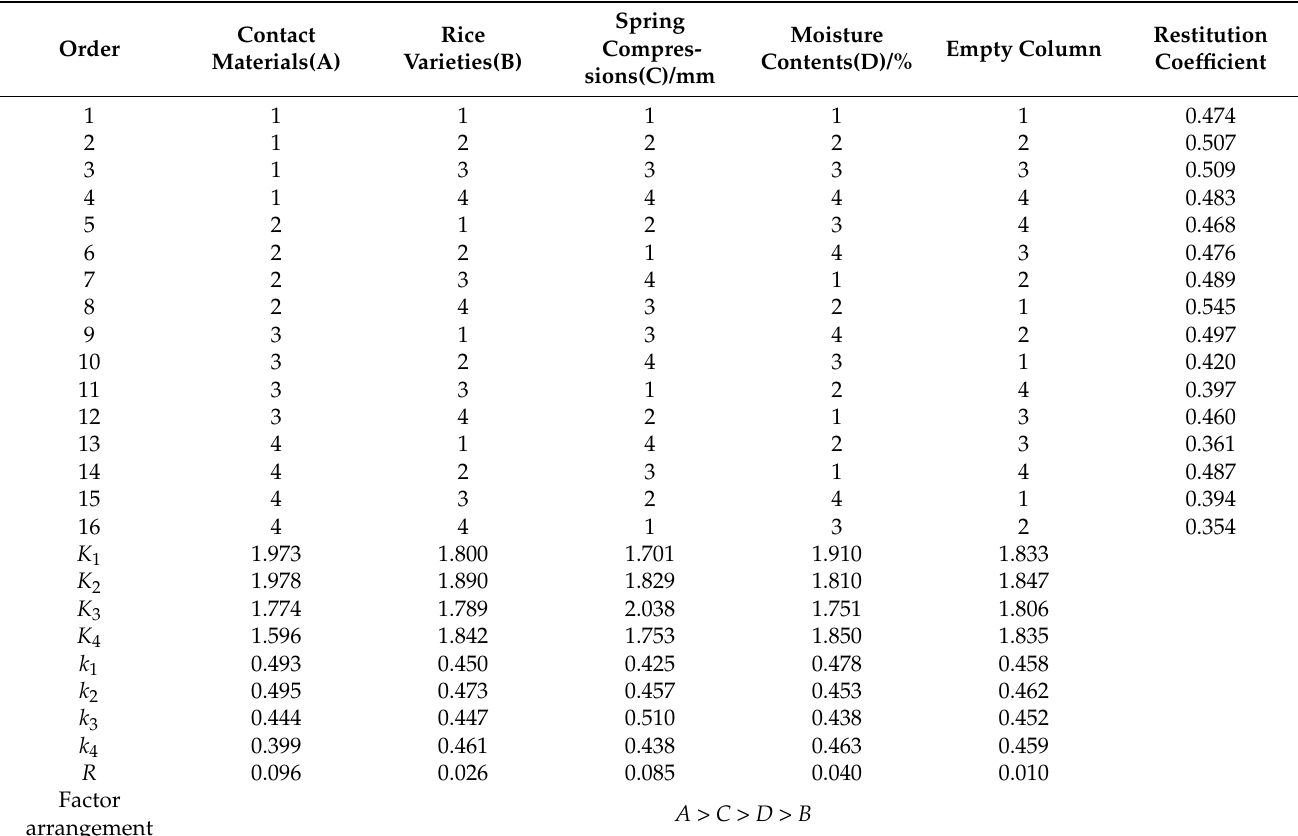
Table 4. Orthogonal test scheme and results of restitution coefficient.